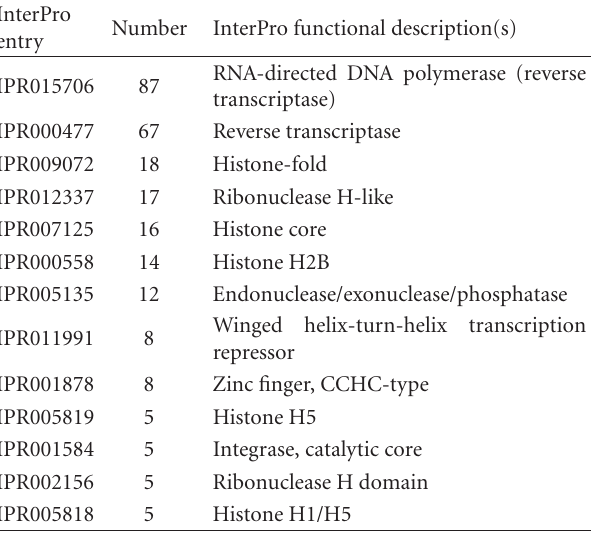
Table 1: The number of InterPro accessions obtained during annotation of D . v . virgifera BAC end